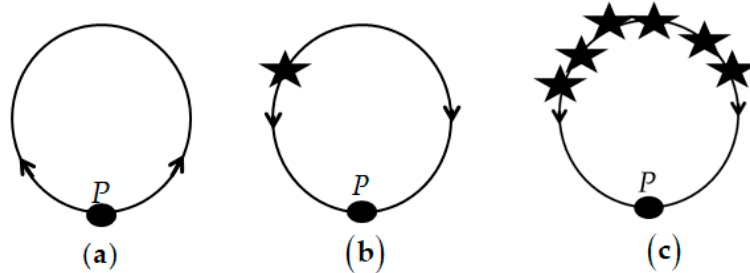
Figure 2. Possible observational effects in the rotating and expanding models independent of the magnitude of the angular velocity of the Universe: ( a ) cosmological mirror effect; ( b ) cosmological lens effect; ( c ) cosmological shadow effect.